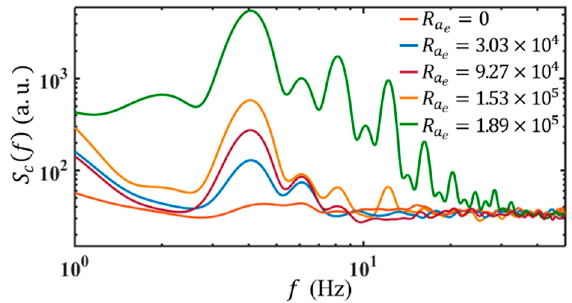
Figure 11. Temporal power spectra of concentration under f f = 4 Hz and different electric Rayleigh numbers. Here Q = 3 µ L/min and the conductivity ratio is 1:5250.